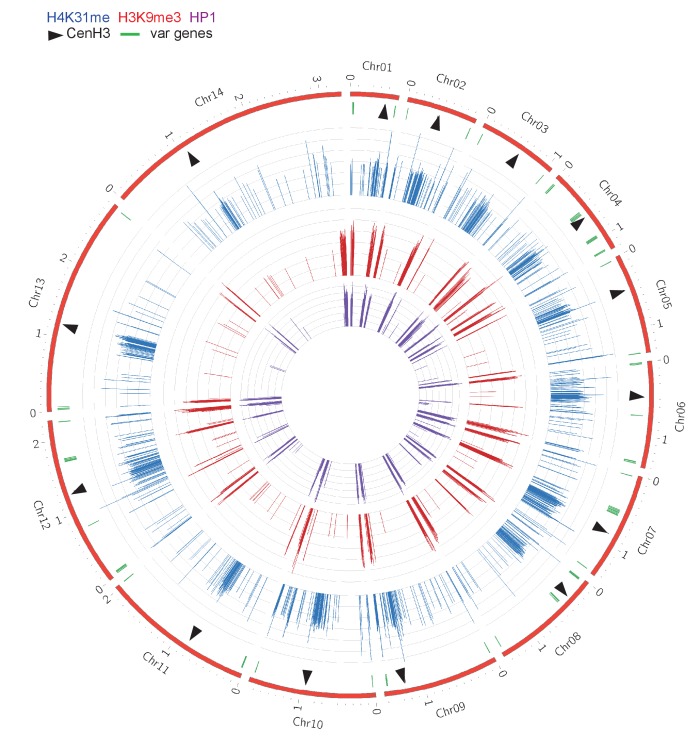
Chromosomal projection of H4K31me1, H3K9me3 and HP1 occupancies in P. falciparum.The full set of chromosomes is represented in this circular plot, in which centromeric regions are marked by black arrows.